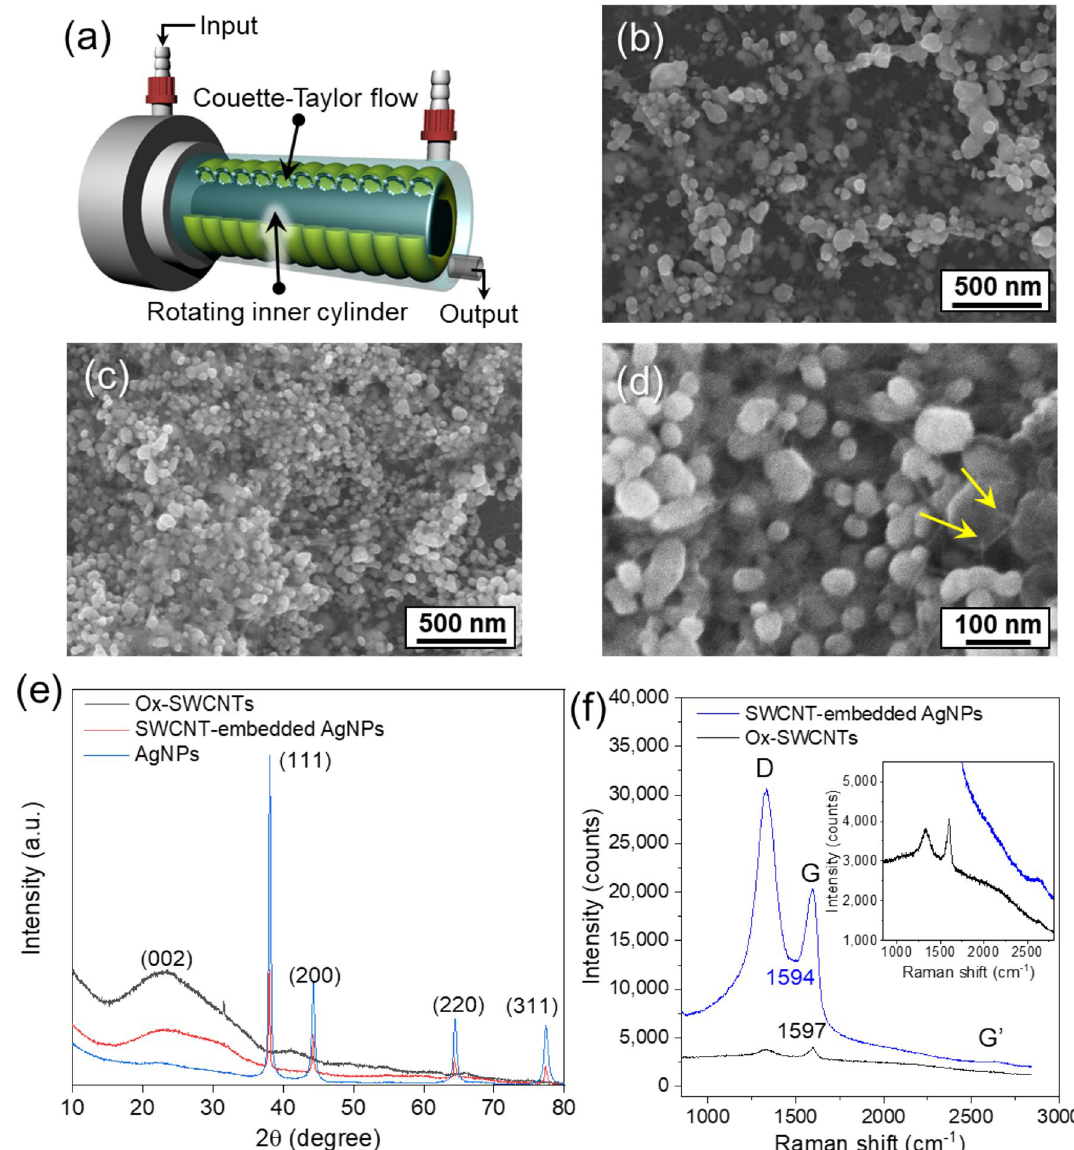
Figure 3. ( a ) Illustration of the Couette–Taylor reactor. FESEM image of SWCNT-embedded AgNPs in the C–T reactor by varying the feeding rate of the reducing agent, NaBH 4 ; ( b ) 5 ml min −1 , ( c ) 50 ml min −1 . ( d ) Magnified FESEM image of ( c ). ( e ) XRD pattern of SWCNT-embedded AgNPs. ( f ) Raman spectra of Ox-SWCNTs and SWCNT-embedded AgNPs by 5 s data accumulation. Inset in ( f ) is a magnified Raman spectrum of Ox-SWCNTs with a weak peak